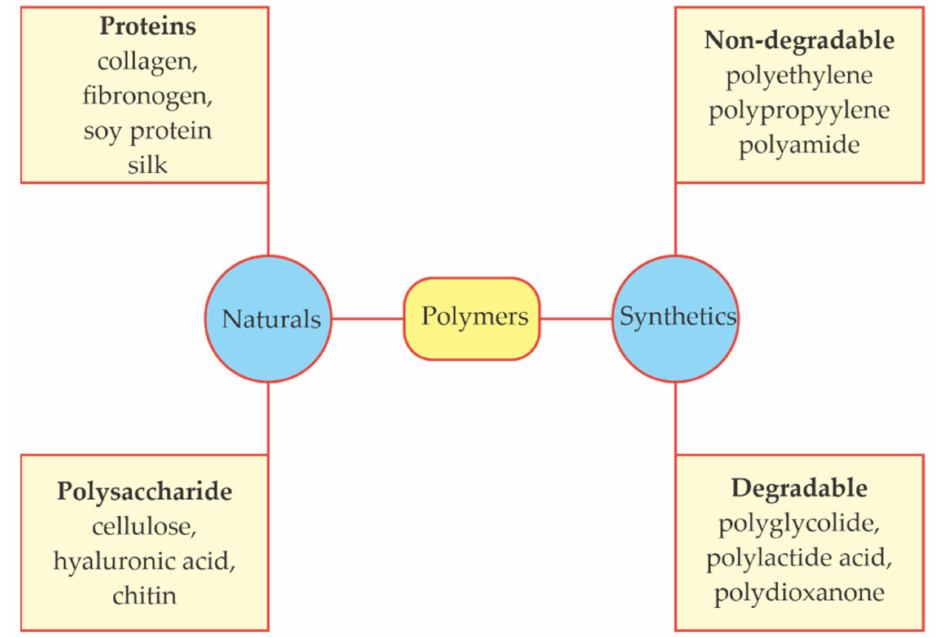
Figure 8. Examples of biodegradable and non-biodegradable natural and synthetic polymers. Adapted from